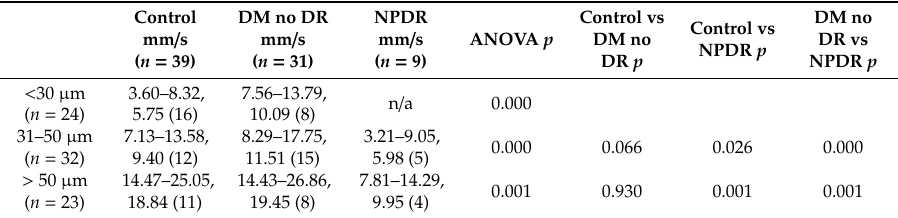
Table 4. Summary of venular blood velocity by vessel diameter groups, comparing healthy controls, diabetes without retinopathy, and non-proliferative diabetic